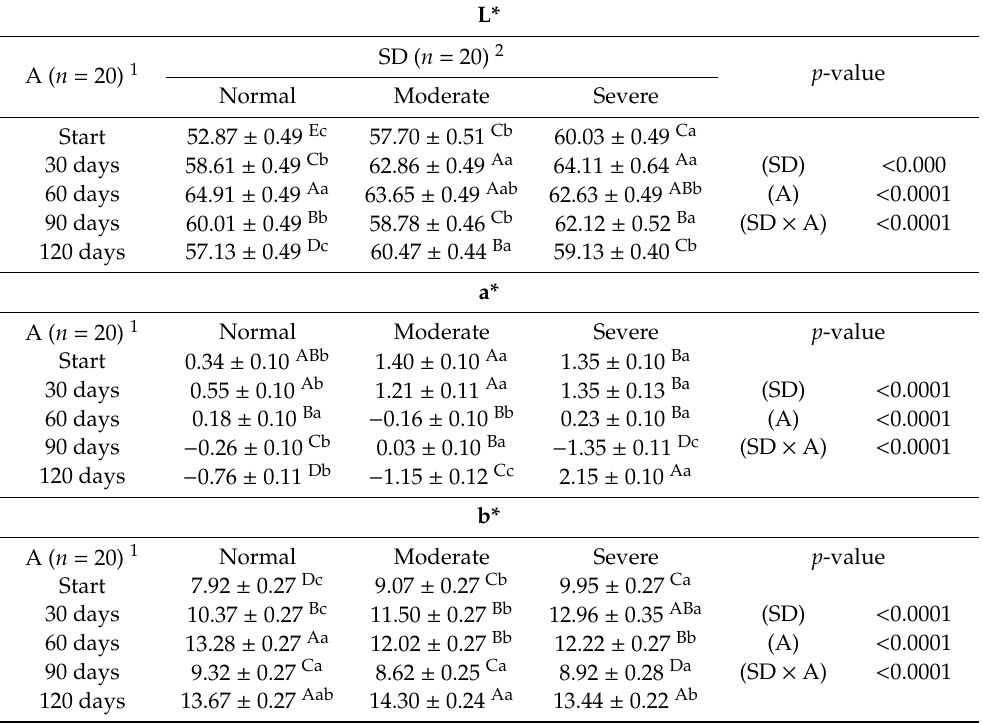
Table 2. Lightness (L*), redness (a*) and yellowness (b*) mean values of hamburgers produced with chicken breast of Ross broiler chickens (AP95) without myopathies and a ff ected by wooden breast myopathy after di ff erent storage